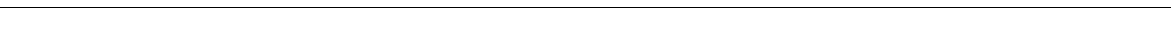
Figure 8 | E2f1 is a major contributor to muscle growth and function in post-fused indirect flight muscles. ( a , d ) Muscle size is reduced in E2f1-depleted muscles ( Act88F 4 E2f1-RNAi ), whereas E2f2 mutant muscles are normal. Transverse sections stained with Phalloidin and b -PS integrin (ventral to the bottom, top panel). DLM4 is magnified (middle panel). Scale bar, 50 m m. Representative images are shown. Quantification of DLM4 cross-section area per fly (mm 2 ), mean ± s.e.m., Mann–Whitney test, ** P o 0.01. ( a ) n ¼ 6, ( d ) n ¼ 3,4 flies per genotype. Expression of E2f1 ( a , bottom right panel) and Arp53D ( b , bottom right panel) in flight muscles measured by RT–qPCR. Mean ± s.e.m., N ¼ 3 independent samples per genotype, Mann–Whitney test, * P o 0.05. ( b , e ) Myofibril width is slightly reduced in Act88F 4 E2f1-RNAi , whereas in E2f2 mutant it is normal. Confocal images of DLMs in a sagittal view stained with Phalloidin. Scale bar, 10 m m. Profile plot of phalloidin intensity over distance (bottom left panel). A line perpendicular to myofibril orientation was drawn to determine the number of myofibrils per distance. Quantification of myofibril width ( m m; bottom right panel), mean ± s.e.m., Mann–Whitney test, ** P o 0.01. ( b ) n ¼ 7,8, ( e ) n ¼ 6 hemithoraces per genotype. ( c , f ) Flight performance is poor in Act88F 4 E2f1-RNAi adult flies, whereas in E2f2 mutant it is normal. Female flies were flipped into a mineral-coated column, and the frequency of flies landing over the height of the column was scored. Box plots (Min to Max), Mann–Whitney test, *** P o 0.001. Three independent experiments were conducted. ( c ) n ¼ 147,205, ( f ) n ¼ 90,91 flies per genotype. ( g , h ) Muscle-specific gene expression is compromised in Act88F 4 E2f1-RNAi flight muscles of pharate, whereas no gross alteration is found in E2f2 mutant. Genes are how , fln , Lmpt , sals , Tm1 , Mef2 , Tm2 , Mhc , Act88F, Mlc2 and salm . Mean ± s.e.m., N ¼ 3 independent samples per genotype, two-way ANOVA, * P o 0.05, *** P o 0.001. Genotypes ( a – c , g ) Act88F-GAL4;UAS- mCherry-RNAi and Act88F-GAL4;UAS-E2f1-RNAi , ( d – f , h ) E2f2 c03344 / þ and E2f2 c03344 / E2f2 76Q1 . Pharate (P96 h APF, a , b , g ) and adult flies ( c , d – f , h ). NATURE COMMUNICATIONS|7:10509|DOI: